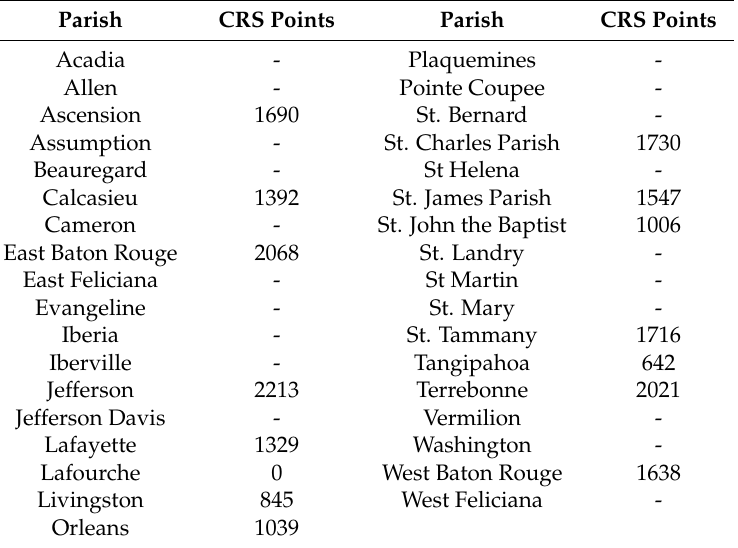
Table 3. Parishes and CRS points in the study